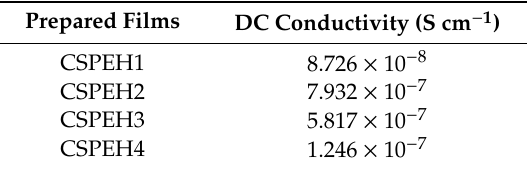
Table 3. Computed direct current (DC) ionic conductivity for the chitosan:poly(ethylene oxide) (CS:PEO) blend electrolyte sample.